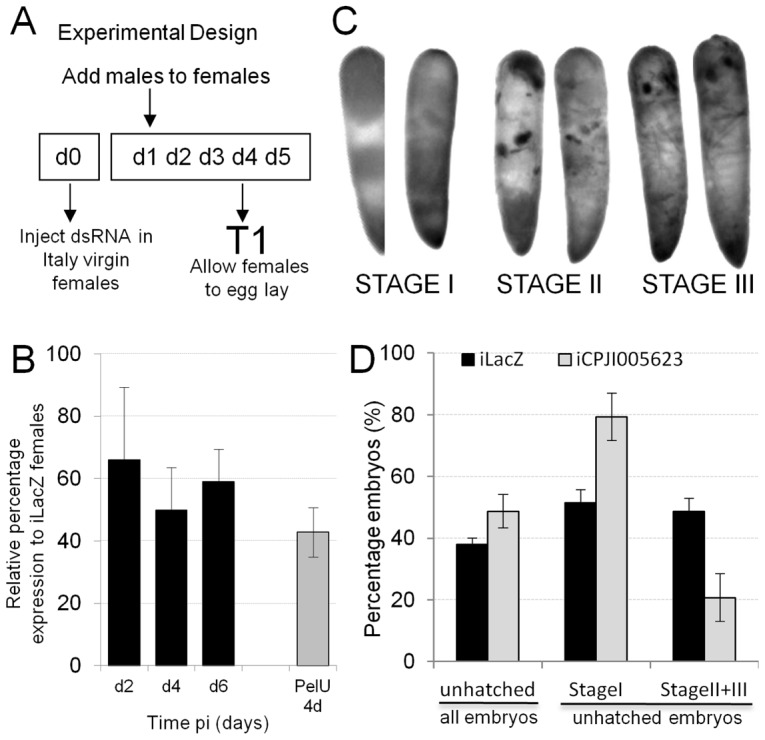
Knockdown analysis of CPIJ005623 in C. molestus Italy females.
A. Diagram representing experimental design of knockdown (KD) experiments, d-day post pupal eclosion, T-time point. B. KD assessment of iCPIJ005623 in Italy ovaries. Reduction of CPIJ005623 mRNA levels similar to uninfected ovaries was observed in infected ovaries when CI developmental progression was seen. C. Picture examples of developmental progression in Culex embryos undergoing CI, Stage I: early arrest, Stage II and III: late arrest. D. Increased percentage of unhatched embryos mimic a reduced rescue function. Also increased early embryo (stageI) developmental arrest is detected after iCPIJ005623 in compatible Italy male cross.